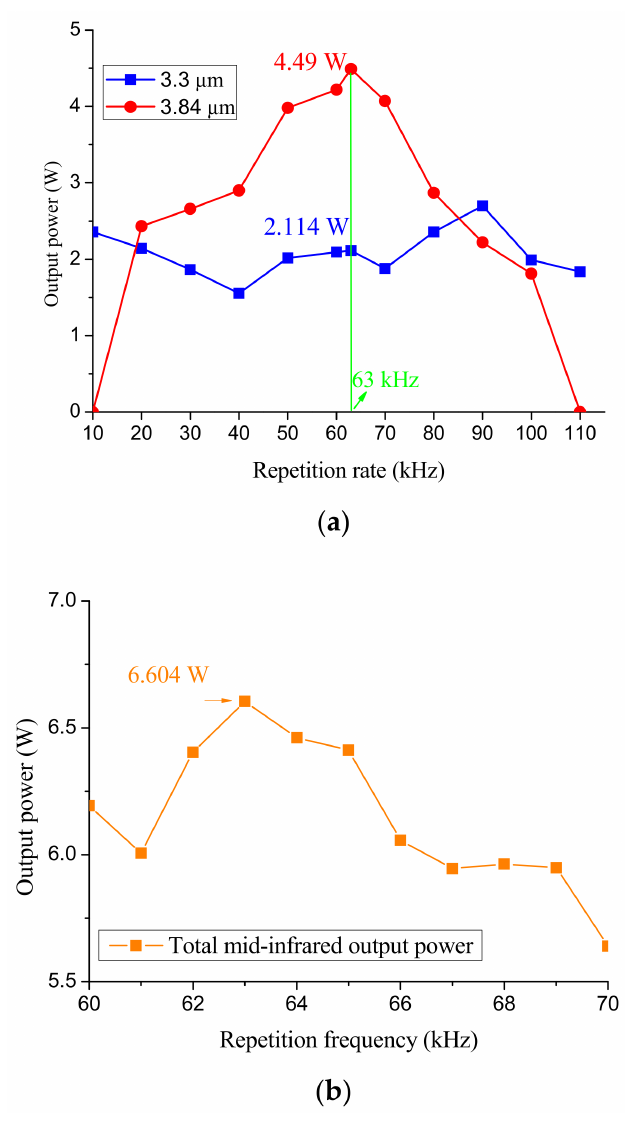
Figure 4. The output power of mid-infrared lasers at different repetition rates. ( a ) The output power of mid-infrared lasers @20~100 kHz. ( b ) The total power of dual-wavelength @60~70